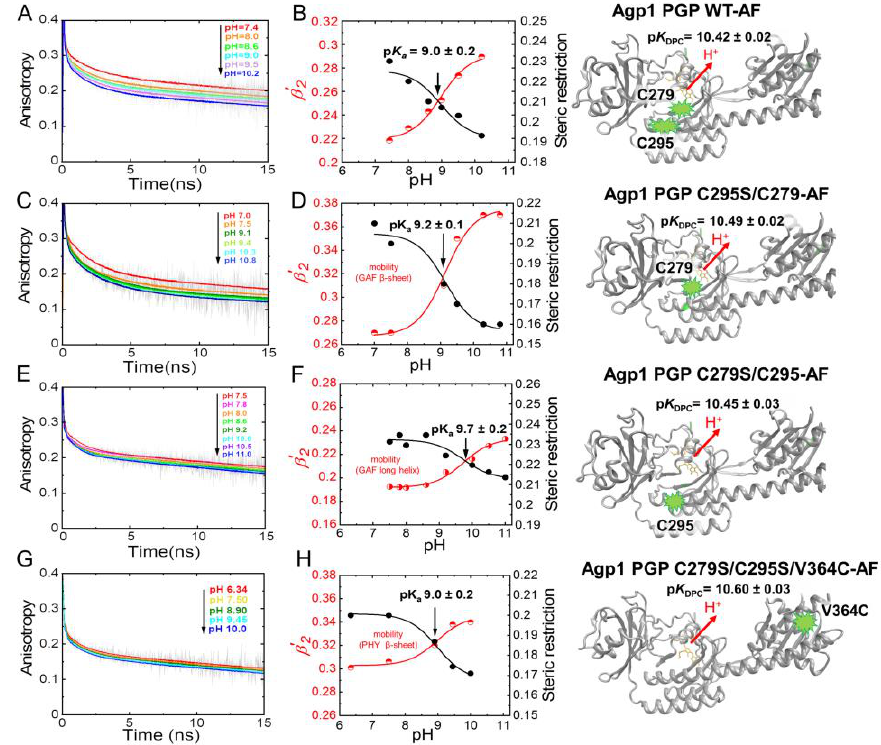
Figure 7. pH-dependent time-resolved fluorescence anisotropy data for Agp1 variants. ( A , C , E , G ) show the anisotropy decay curves (grey) and the respective fits (colored) at the different pH. ( B , D , F , H ) show the titrations curves of β -sheet flexibility expressed as the relative mobility β (cid:48) 2 = β 2 /( β 2 + β 3 ) (red data points), and of the steric restriction of the respective protein segment by the surrounding protein constituents expressed by β 3 (black data points). The p K a values of the pH-dependent conformational changes were obtained by global fitting of steric restriction and β (cid:48) 2 using Equation (2). The fit curves are shown. The respective p K a values are given. ( A , B ) Agp1 PGP WT-AF, ( C , D ) Agp1 PGP C295S/C279-AF, ( E , F ) Agp1 PGP C279S/C295-AF, and ( G , H ) Agp1 PGP C279S/C295S/V364C-AF. The chromophore p K a values are depicted alongside with the structural models at the right. The anisotropy fit values are summarized in Tables 2 and 3. Conditions: 300 mM NaCl, 50 mM Tris, at 19 ◦